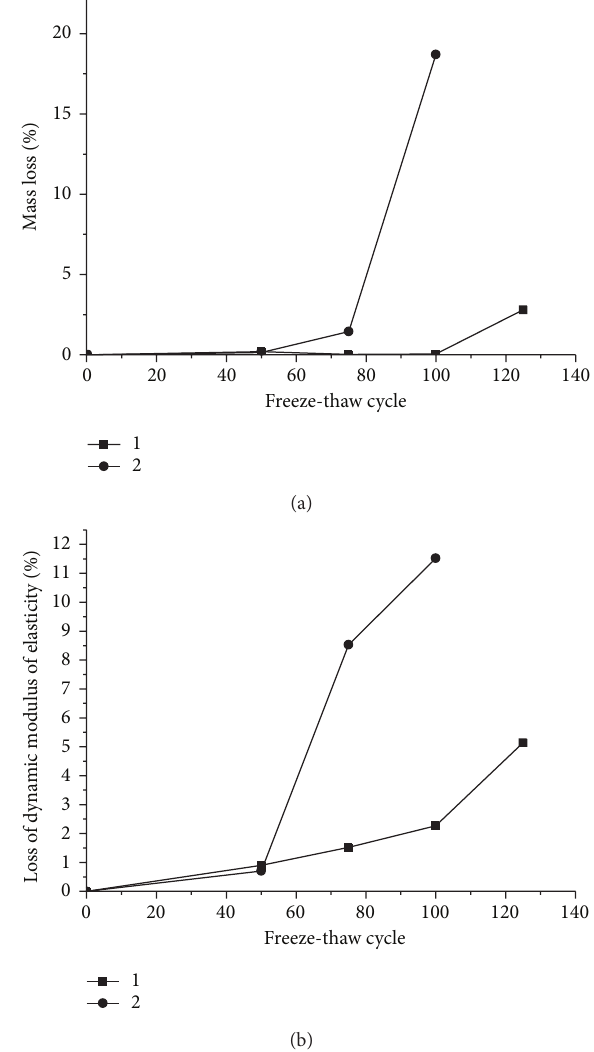
Figure 5: Freeze-thaw test results for standard samples (a) mass loss and (b) loss of dynamic modulus of